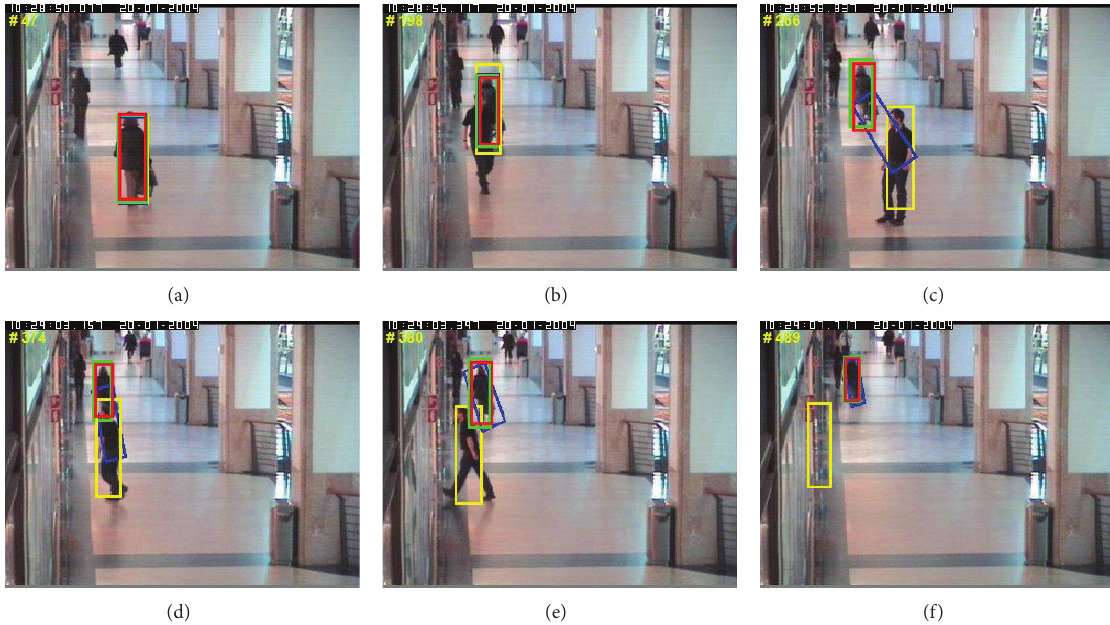
Figure 8: Tracking results of the OneLeaveShopReenter2cor sequence (MIL is yellow, IVT is blue, L1 is green, and our tracker is red).